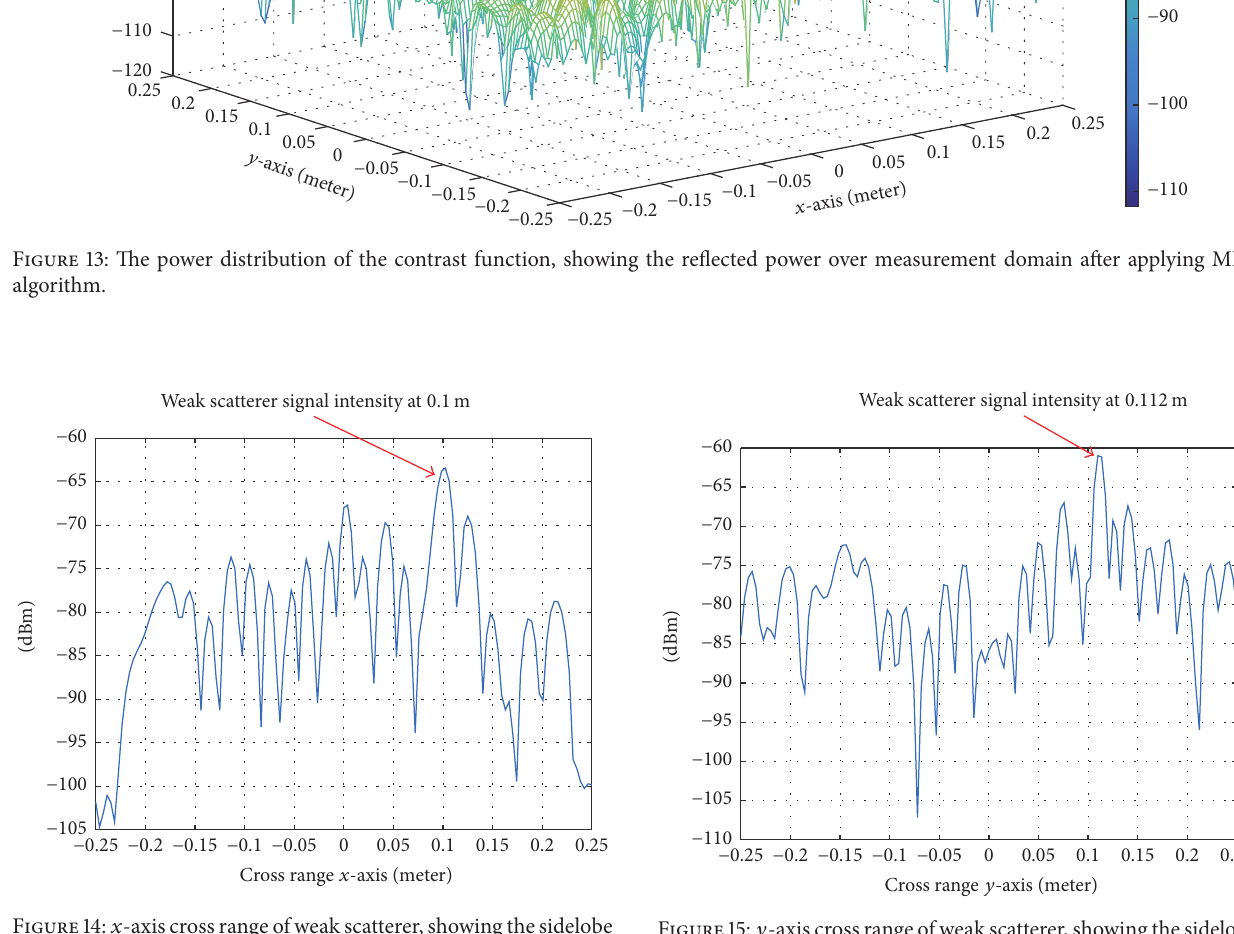
Figure 15: 𝑦 -axis cross range of weak scatterer, showing the sidelobe suppressing weak scatterer signal after applying MRL